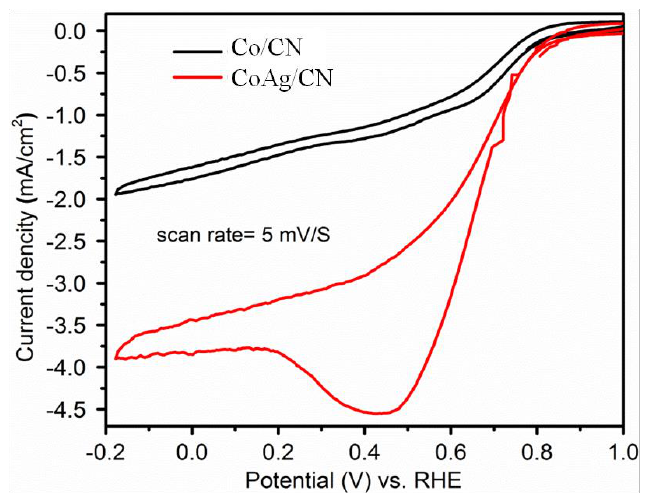
Figure 6. ( a ) Cyclo voltammogram diagram of Co/CN after N 2 and O 2 purge. ( b ) Cyclo voltammogram of CoAg/CN after N 2 and O 2 purge. ( c ) CV comparison of Co/CN and CoAg/CN at scan rate of 5mV/sec ( d ) CV of CoAg/CN at different scan rates .